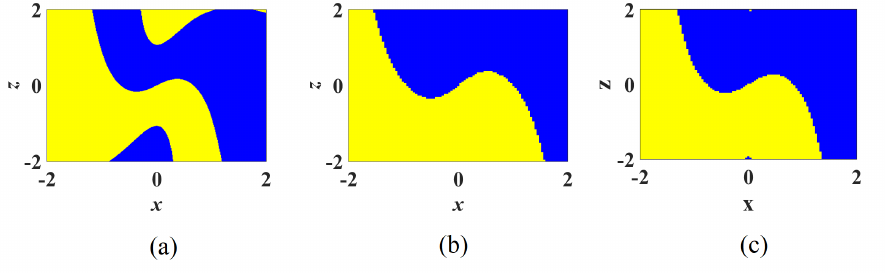
Figure 8. The basins of attraction in x-z plane. ( a ) k = 1.4, ( b ) k = 1.3, ( c ) k =